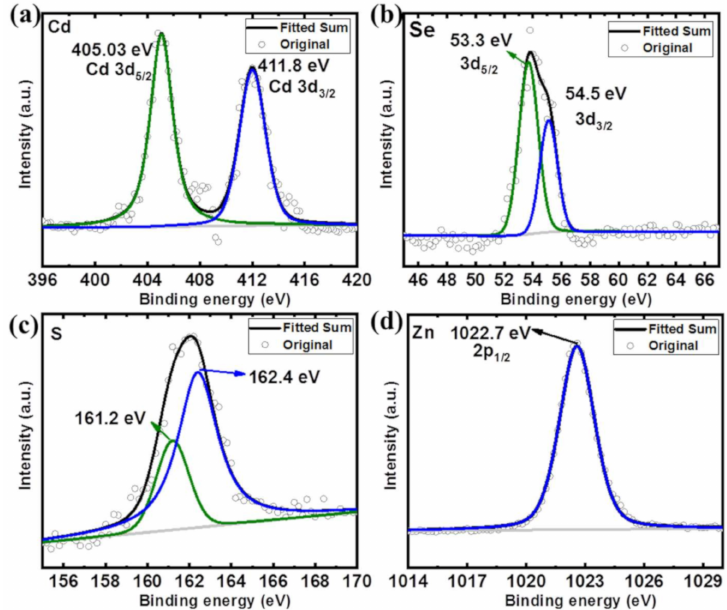
Figure 5. The XPS spectra of ( a ) Cd 3d, ( b ) Se 3d, ( c ) S 2p, and ( d ) Zn 2p in the QDs-OLA 0.